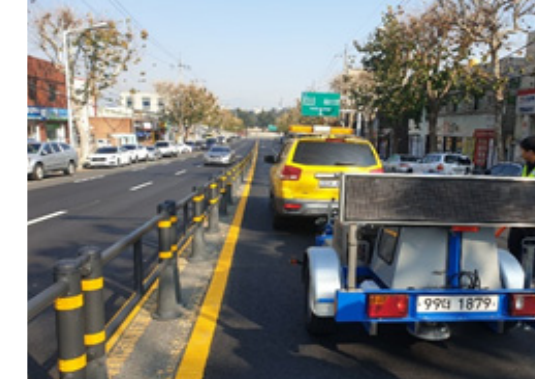
10 of 21 Figure 7. Schematic diagram of test field construction and cross-section. Figure 8. Actual pavement construction. 3.2. Falling Weight Deflectometer Test As shown in Figure 9, this study used the FWD test to evaluate the pavement struc- ture after field test construction. The analysis was performed to compare the structural characteristics of each section. This is considered the non-destructive testing device used to evaluate the physical properties of pavement structures by subjecting the surface to an impact load and obtaining the surface deflection bowl measured by a series of sensors installed on the pavement surface. The standard load is 4082 kgf, and the diameter of the load plate is 30 cm. When a dynamic load is applied, the geophones measure the deflection at each location [46–48]. The deflection bowl is calculated from the measured FWD deflec- tions, Dr, at geophones positioned at different offsets, r in mm, from the center of loading. Deflections resulting from dropped weights such as 4082 kgf are measured at these offsets [49]. These discrete measuring points are illustrated in Figure 10. The discrete measured